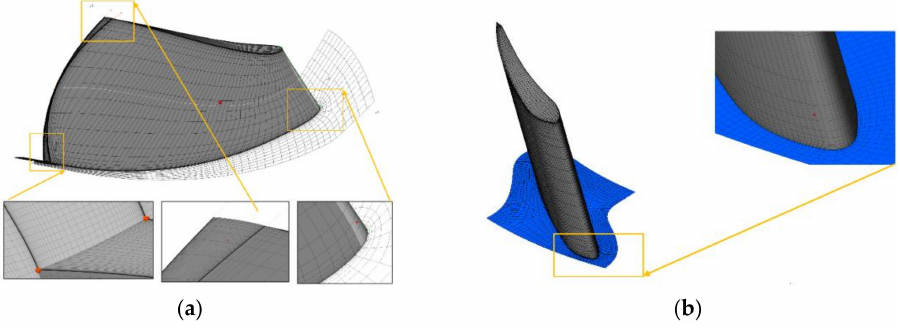
Figure 1. ( a ) Rotor blade mesh ( b ) Stator blade mesh. Table 2. Mesh intensity